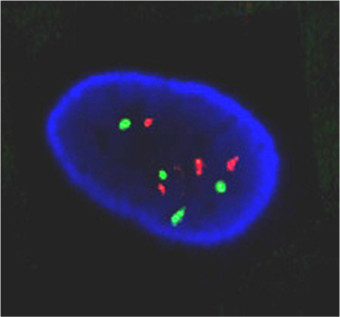
FISH analysis showing 4 signals for HER-2 (red) and 4 signals for the chromosome 17 centromere (green) in A549 cells.